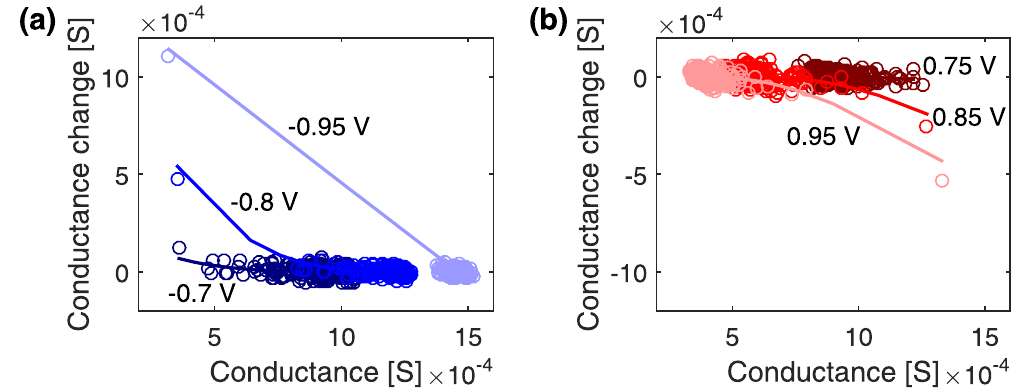
Figure 5. Conductance increment as a function of the conductance level. ( a ) Potentiation operations with Δ t = 10 μ s and Δ V = − 0.7 V, − 0.8 V and − 0.95 V. ( b ) Depression operations with Δ t = 100 μ s and Δ V = 0.75 V, 0.85 V and 0.95